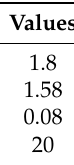
Figure 9. ( a , b ) The images data and Lidar point cloud data. ( a ) The corner detection in image data. ( c ) The point image data is the projection of Lidar data onto image data. ( d ) The person is detected in the image data and ( e ) The re-projection of that detection in the Lidar data (Best viewed in color). Table 3. Ground Plane Removal Filter Experimental